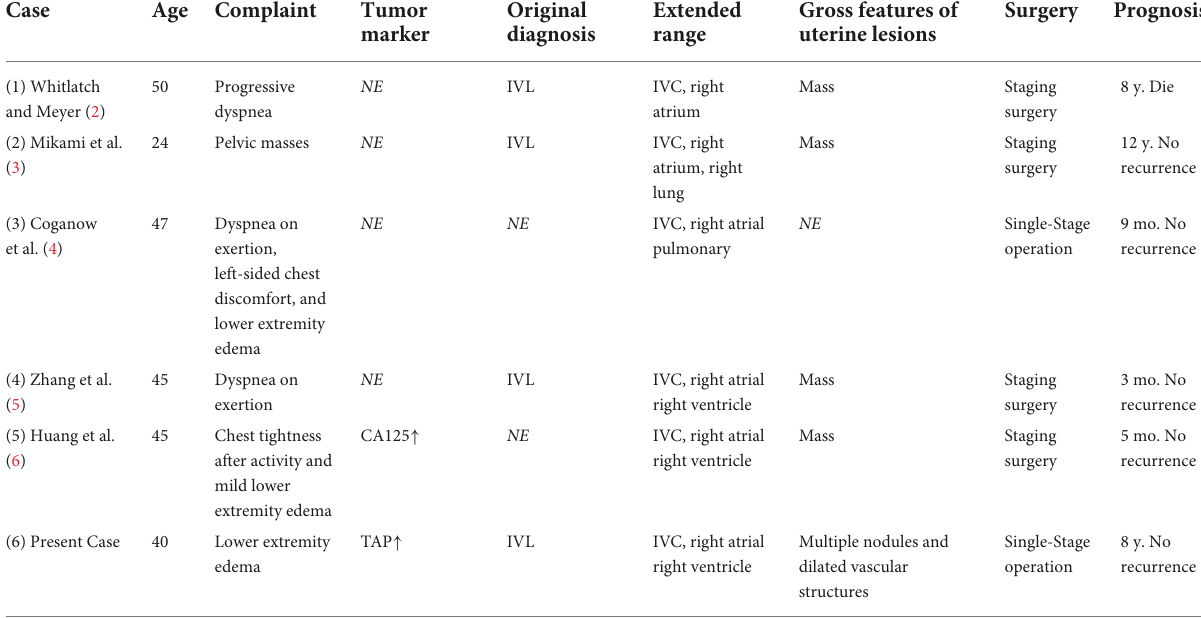
TABLE 1 Clinical features of previously reported and current study cases of mixed endometrial stromal and smooth muscle tumor (MESSMT) with intracardiac extension.